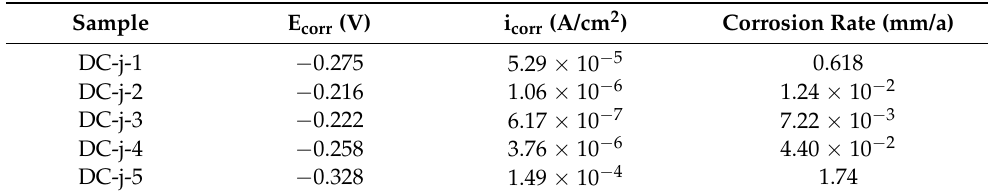
Table 3. The corrosion parameters of the Ni-Co/WS 2 nanocomposite coatings under different current densities.